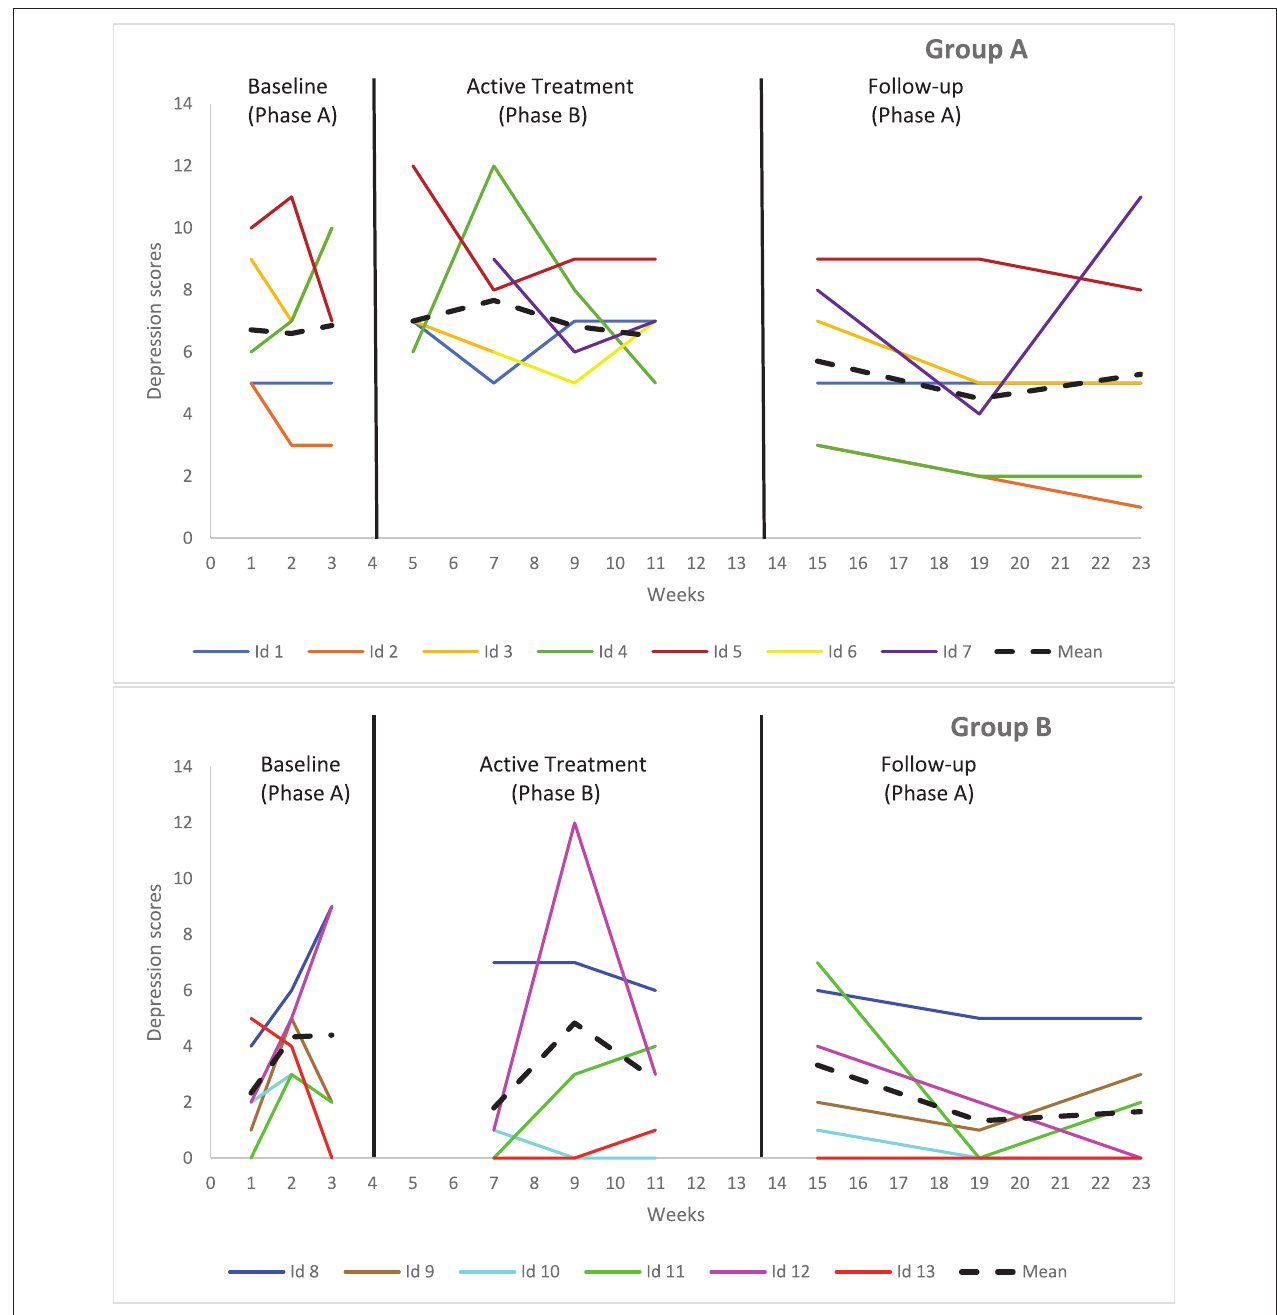
FIGURE 3 | Graphical display of baseline level and changes in level between consecutive phases in depression for self-reported